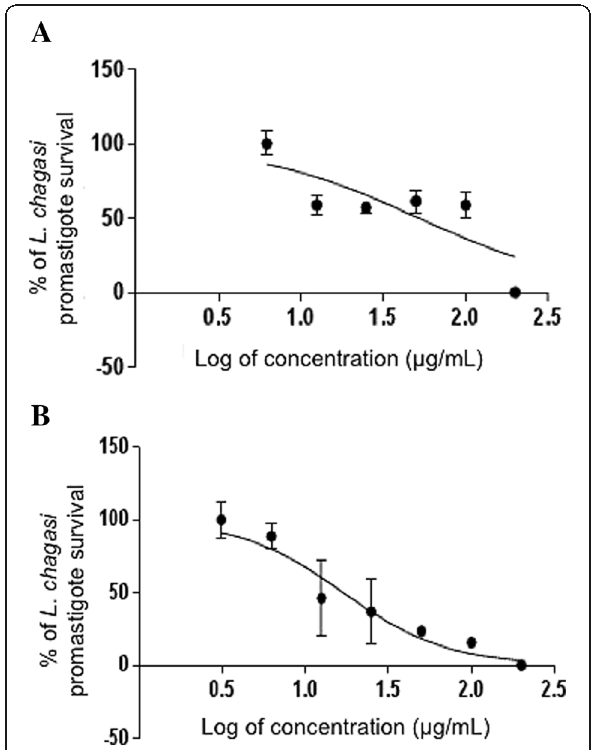
Fig. 3 a Dose-response curve of MTT assay for leishimanicidal activity of PLA 2 and ( b ) of peptide fraction from Crotalus durissus terrificus venom in promastigotes of Leishmania (L.) infantum chagasi